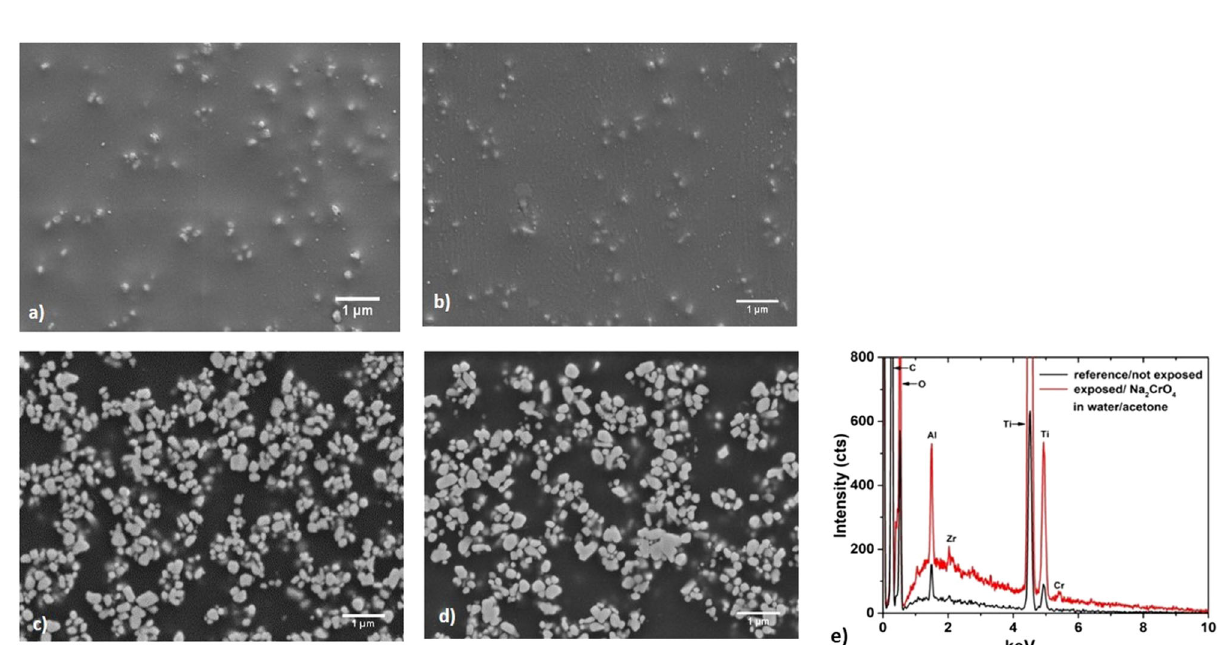
Fig. 2 SEM/EDS analysis of 30TiO 2 fi lms. a SEM image of 30TiO 2 surface before exposure. b SEM image of 30TiO 2 surface after 24 h exposure to Na